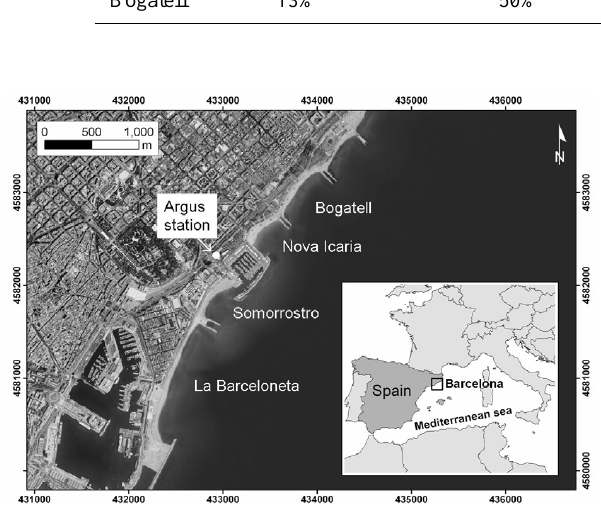
Fig. 1. Study area and location of the Argus station at Barcelona Figure 1. Study area and location of the Argus station at Barcelona city, Bogatell and La Barceloneta being the studied beaches. The coordinates are given in city, Bogatell and La Barceloneta being the studied beaches. The UTM (m). coordinates are given in UTM (m).